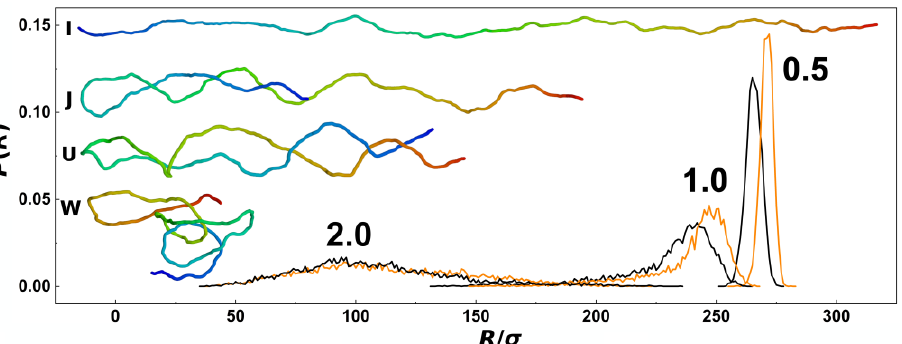
Figure 2. Histograms showing probability distributions of DNA span, R , obtained from simulations of DNA confined in nano-channels without external compressive force. The histograms obtained for cylindrical and helical nano-channels are shown in black and orange colours respectively. The panel shows also snapshots of the DNA chain in a rainbow colour scale from simulations for typical conformations represented by simplified impressions using the letters I, J, U and W. The numbers indicate confinement strength indicated as the D / P ratio 0.5, 1.0 and 2.0.